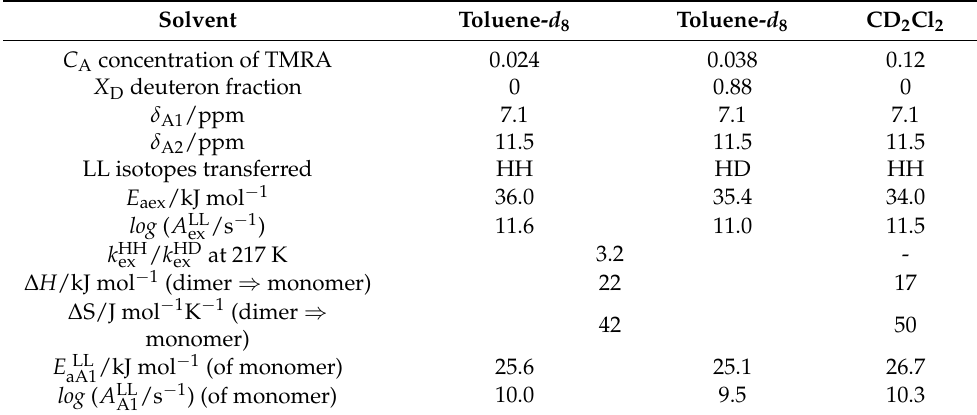
Table 3. Parameters of the tautomerism of TMRA in